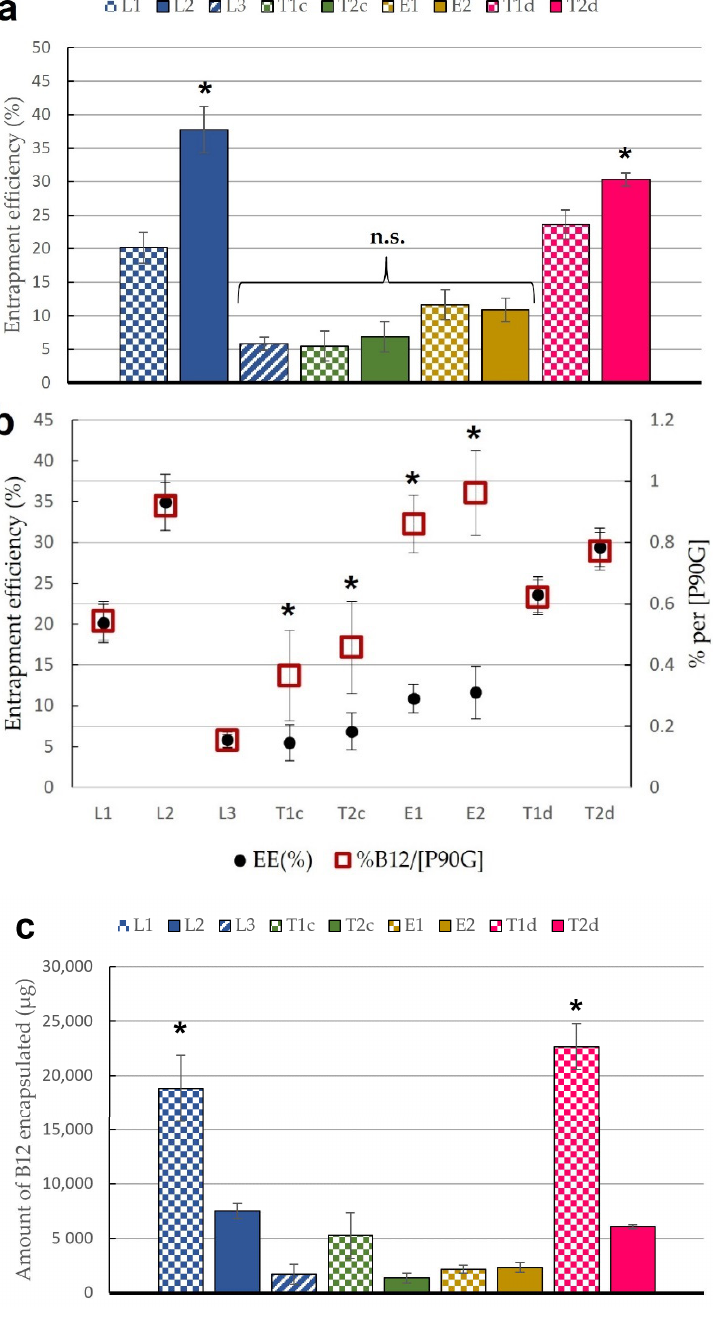
Figure 2. ( a ) Entrapment efficiency (EE) (expressed as a percentage) of the nine prototypes of lipo- somes, transferosomes, and ethosomes; ( b ) Specific entrapment efficiency rate of the nine prototypes of liposomes, transferosomes, and ethosomes; ( c ) Total amount of B12 encapsulated in 10 mL of liposomal suspension ( µ g). All results are expressed as mean ± SD ( n = 3). * means statistically significant differences ( p < 0.05), n.s. means no statistically significant differences ( p > 0.05) using one- way ANOVA followed by Tukey’s multiple comparison test.